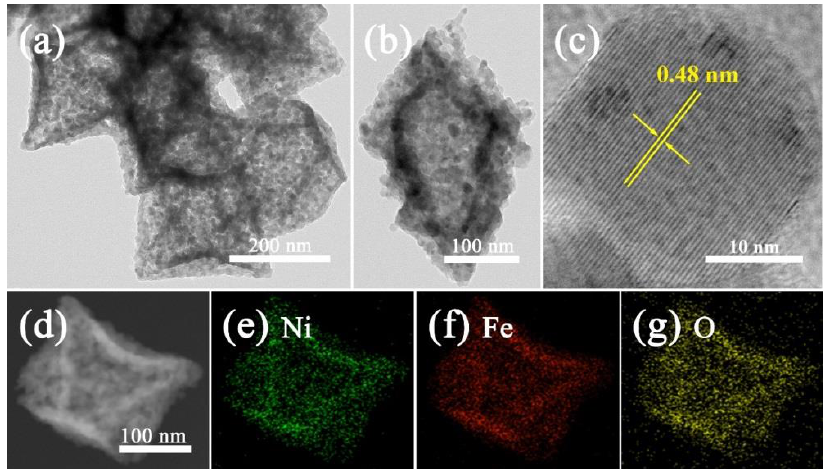
Figure 4. TEM ( a , b ) and HRTEM ( c ) images of the NiFe 2 O 4 nano-octahedrons and elemental mapping images of Ni ( e ), Fe ( f ), and O ( g ) for an individual NiFe 2 O 4 nano-octahedron ( d ).